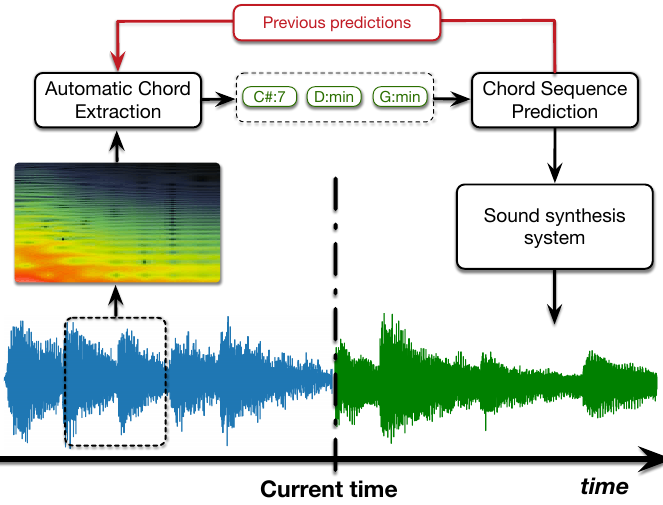
Figure 1. General architecture of the listening and predictive module. For each beat, a sequence of chords extracted in real time from the audio stream is sent to the chord sequence predictive system. The predicted sequence can be sent to a sound synthesis system in order to generate an audio feedback.